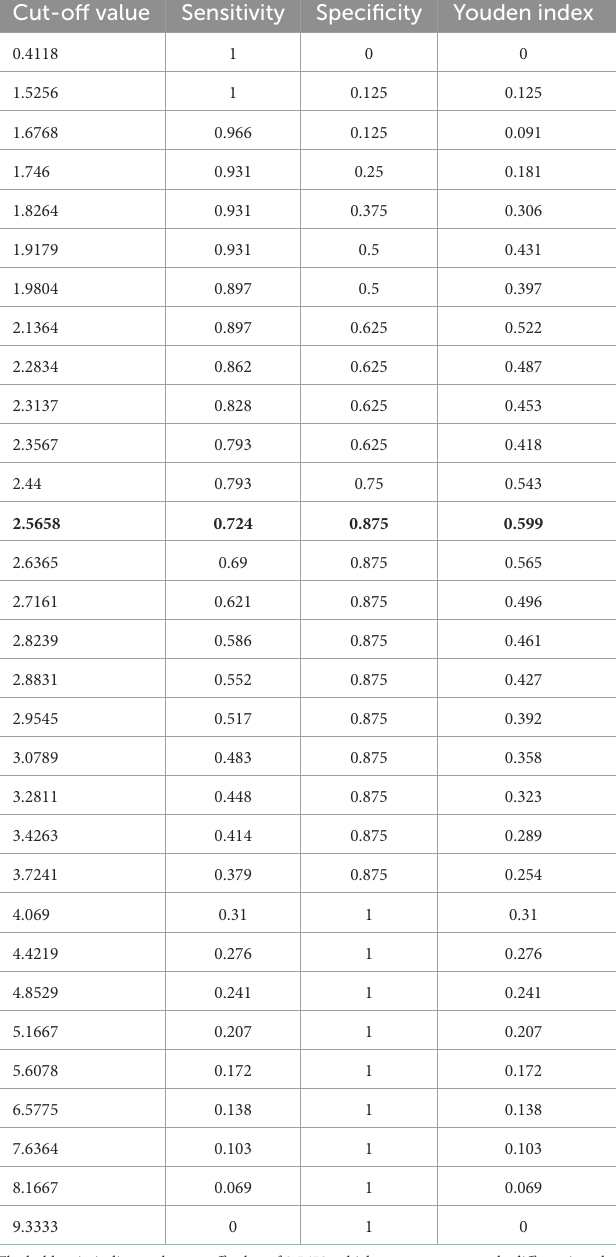
TABLE 6 Determination of the cut-off value for the balloon/waist ratio.